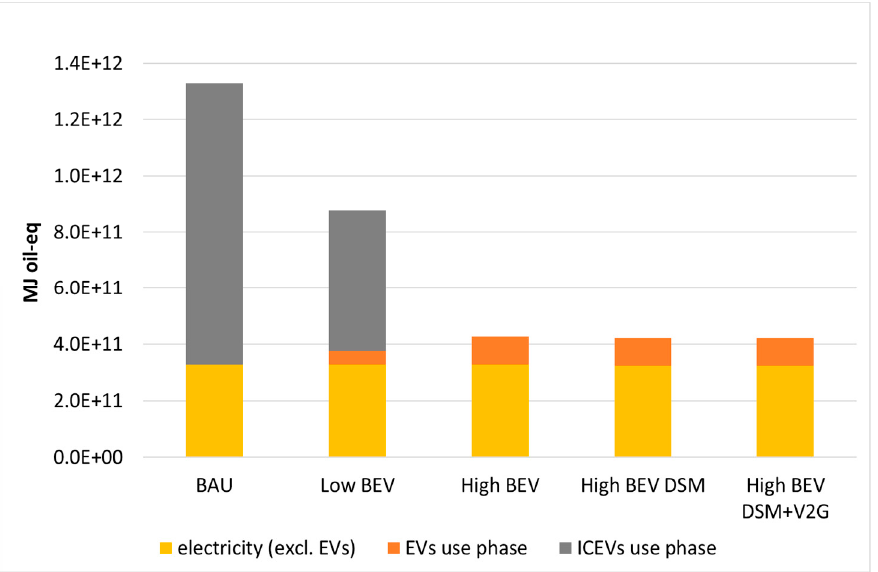
Figure 12. Non-renewable cumulative energy demand (nr-CED) of domestic electricity supply to all non-transport sectors (yellow) + use phase of a 10 million LDV fleet. “BAU” = 10M ICEVs (grey); “Low BEV” = 5M ICEVs (grey) + 5M BEVs (orange); “High BEV,” “High BEV DMS” and “High BEV DMS+V2G” = 10M BEVs (orange).